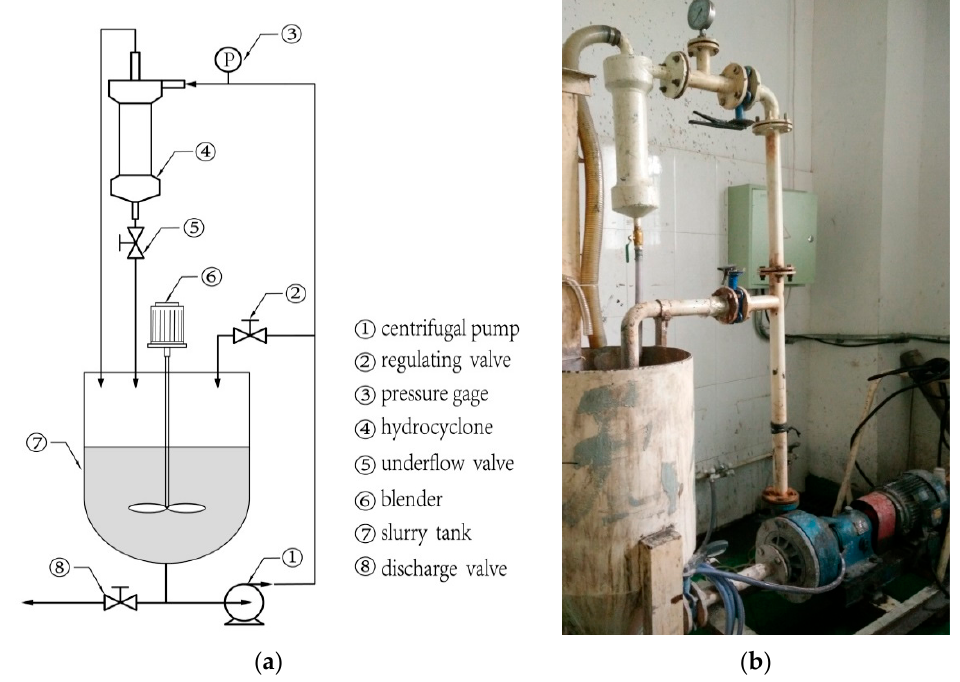
Figure 5. Schematic diagram of the ( a ) experimental system and ( b ) experimental device.